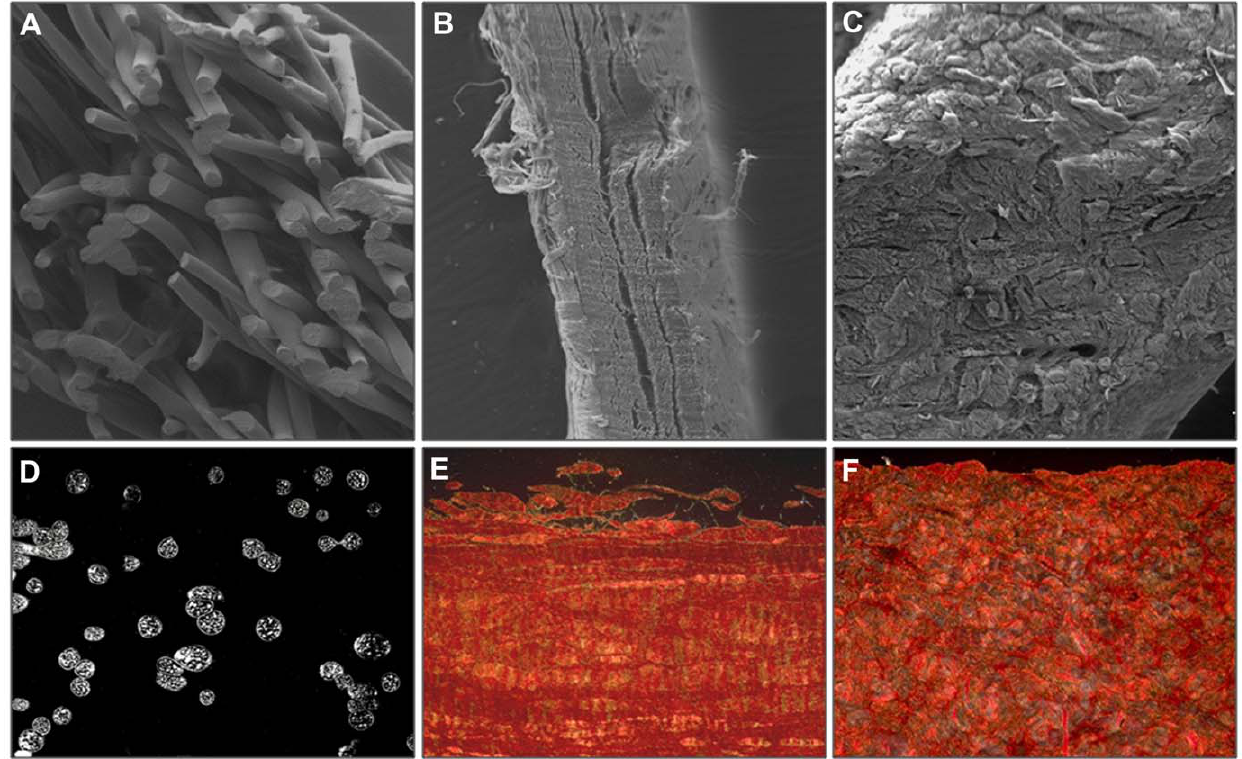
Figure 1. Used biomaterials. Scanning electron microscopy images (100 6 ) showing the aspect and the thickness of Bio-A (A), Tuto (B) and St (C). Polarized light images, with collagen fibers displayed in red after Sirius Red staining (200 6 ). Bio-A (D), Tuto (E) and St (F).